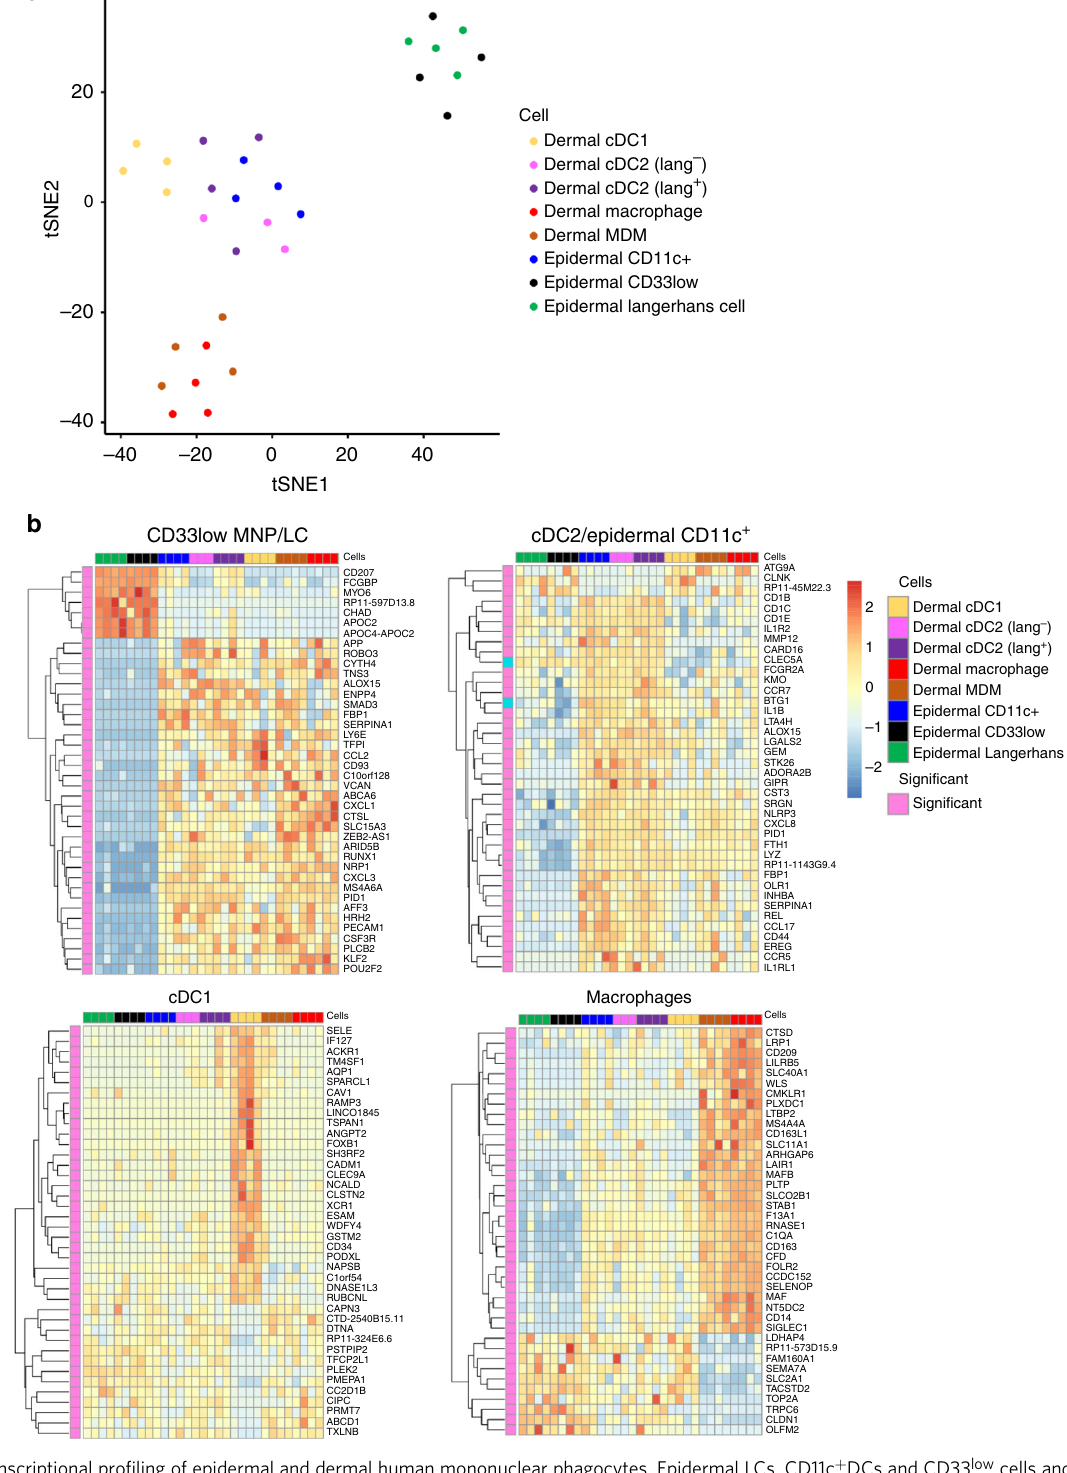
Fig. 2 Transcriptional pro fi ling of epidermal and dermal human mononuclear phagocytes. Epidermal LCs, CD11c + DCs and CD33 low cells and dermal cDC1, cDC2 (langerin + and − ), monocyte derived macrophages and tissue resident macrophages were FACS sorted from 4 individual donors. RNA was ampli fi ed and RNAseq carried out. a A tSNE plot highlights similarities between the cell subsets. b Moderated linear models were used to identify genes whose high or low expression characterised each subset. Heat maps display expression values of the top 40 genes that uniquely identify; CD33low MNPs and LCs; cDC2 and epidermal CD11c; cDC1; and monocyte-derived macrophages and tissue resident